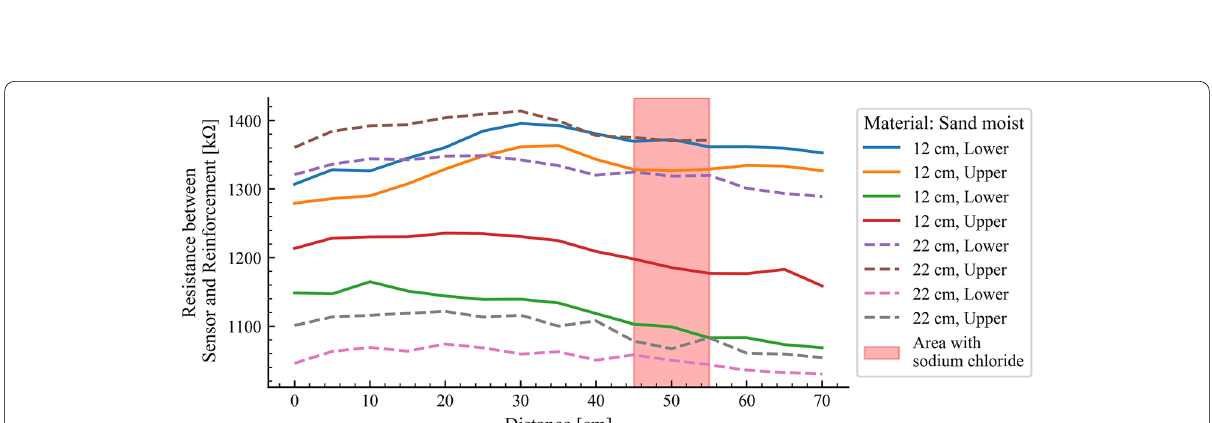
Fig. 11 Electrical resistance between the sensor and the steel reinforcement measured in the wooden frame in the upper and the lower holes (see Fig. 11) filled with sand with varying distances between the sensor and the sample. The red rectangle marks the location treated with sodium chloride while casting the reinforced mortar block